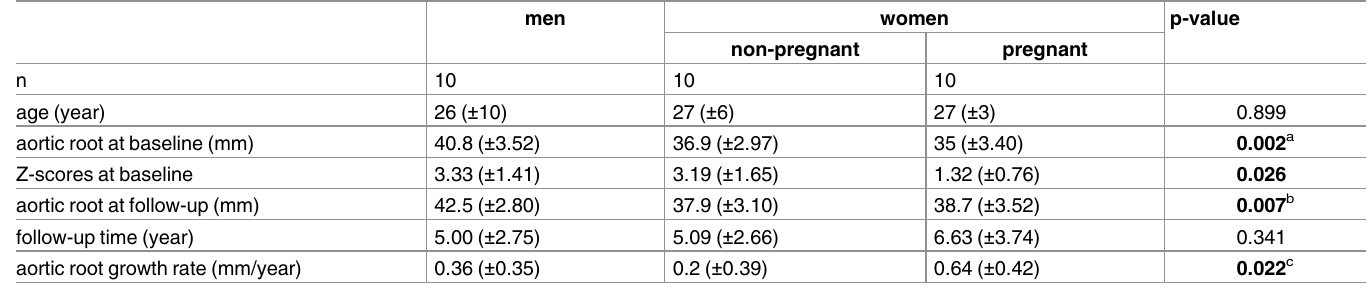
Results are given as means with the standard deviation between brackets. Significant p-values ( < 0.05) are indicated in bold. a Values are significantly different between men and non-pregnant and pregnant women (p = 0.040 and p = 0.002, respectively), but not between the non- pregnant and pregnant women (p = 0.623). b Values are also significantly different when pairwise comparing men and non-pregnant and pregnant women (p = 0.010 and p = 0.038, respectively). c Significant difference only between non-pregnant and pregnant women (p = 0.018). No significant difference was observed between men and non- pregnant (p = 0.559) or pregnant women (p = 0.352).